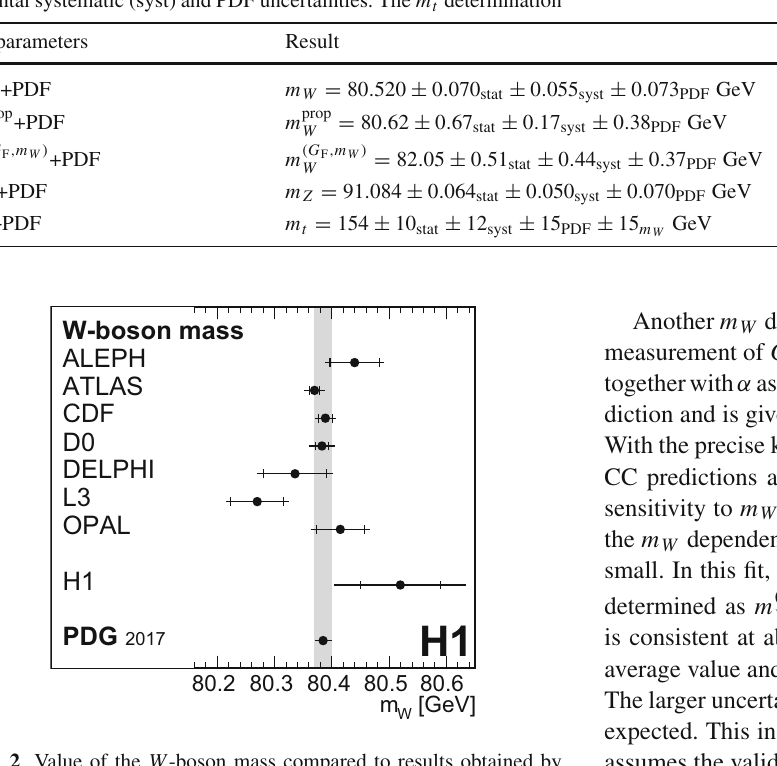
also includes an uncertainty due to the uncertainty of the W mass. The most-right column lists further input parameters not varied in the fit